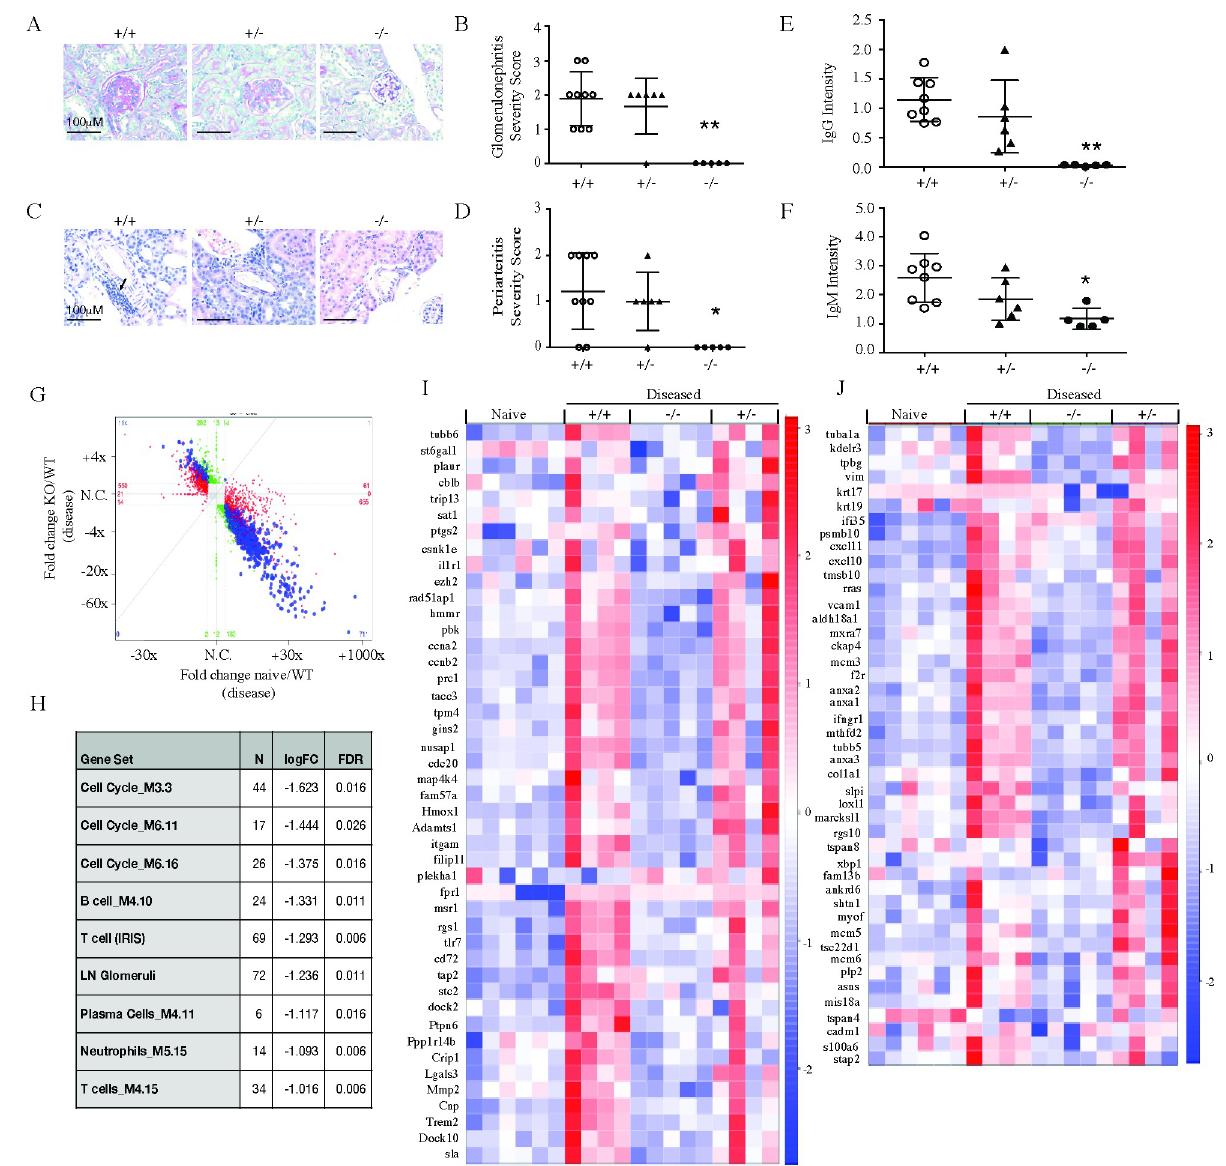
Fig 8. SLC15a4 deficient NZB/W F1 mice are protected from IFN α accelerated lupus nephritis. 7 weeks post rAd-IFN α administration, NZB/W F1 slc15a4 +/+ , slc15a4 +/- and slc15a4 -/- mice were euthanized and kidneys were collected to assess renal disease severity by histology and RNA sequencing. (A-D) Representative images and quantification of histological scoring for glomerulonephritis (A, B) and periarteritis (C, D) are shown. (E-F) Quantification of IgG (E) and IgM (F) immune complex deposition. Data is expressed as mean ± SD. (G) RNA sequencing analysis was performed on kidney RNA. Fold changes between KO and WT at the disease timepoint are compared to those between na ï ve WT and disease WT animals. Each data point represents a gene. Red, green and blue dots represent genes that are significant only in naive versus diseased condition in wildtype (red), only in knockout versus diseased wildtype (green) or both (blue). (H) Gene set enrichment analysis of pre-defined immune and human LN ortholog gene modules are shown. (I-J) Effect of slc15a4 on human LN ortholog genes previously identified to be up-regulated in the glomerulus (I) or tubulointerstitium (J) of nephritic kidneys from human LN patients (see Material and Methods for details). Genes that showed individual significant changes in absence of slc15a4 are indicated ( � 1.5 fold difference between groups with an adjusted p-value < 0.01). Each column in the heatmap represents one animal within each group. � p < 0.05, �� p < 0.005, ��� p < 0.0005. N = 5–7 per